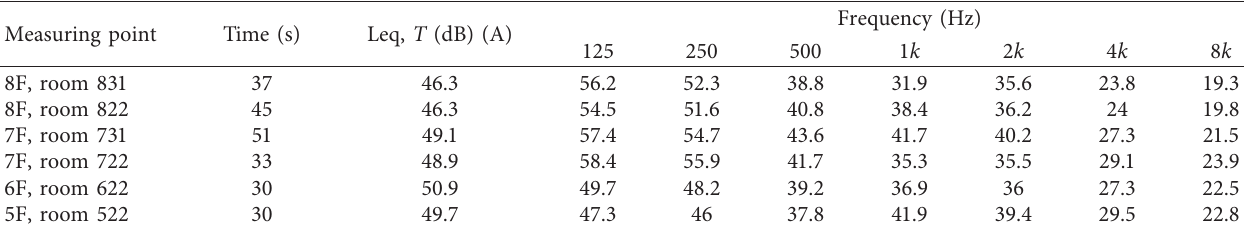
Table 2: Sound pressure levels in the west residential building with windows closed before noise modification. Measuring